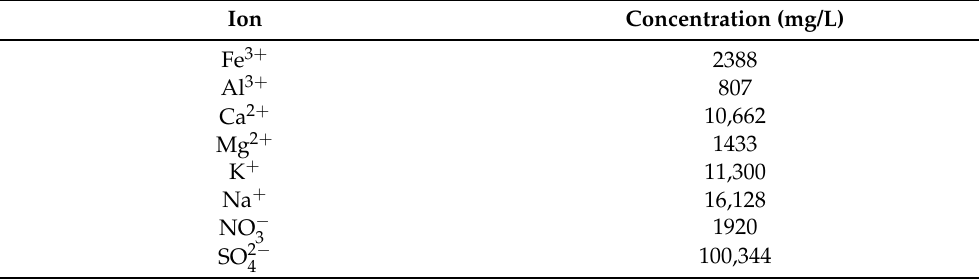
Table 1. Concentration of main cations and anions in ISS.